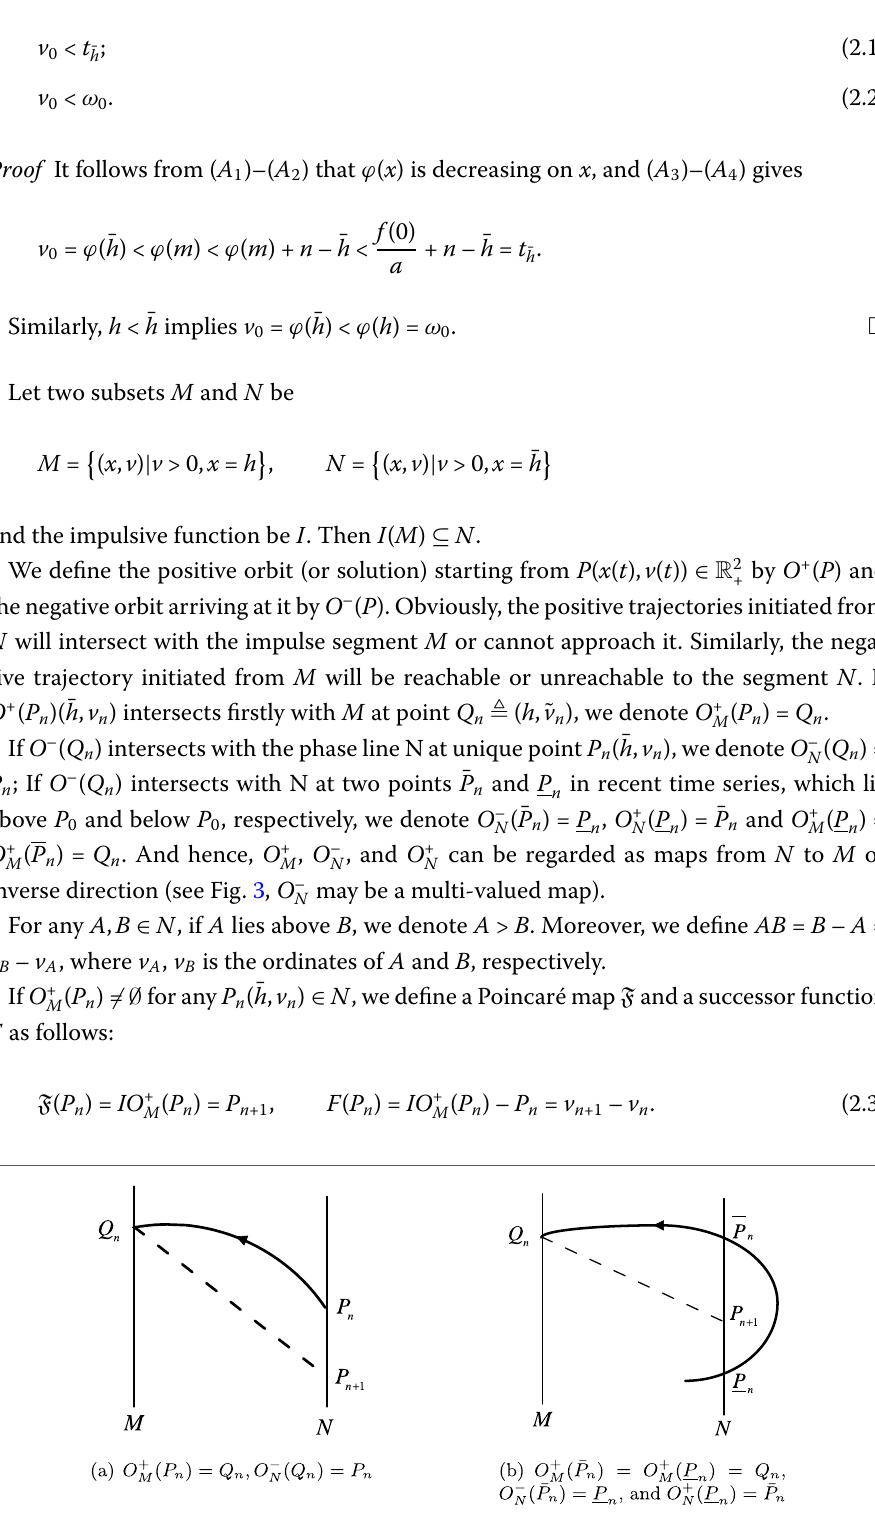
Figure 3 The illustration for O +